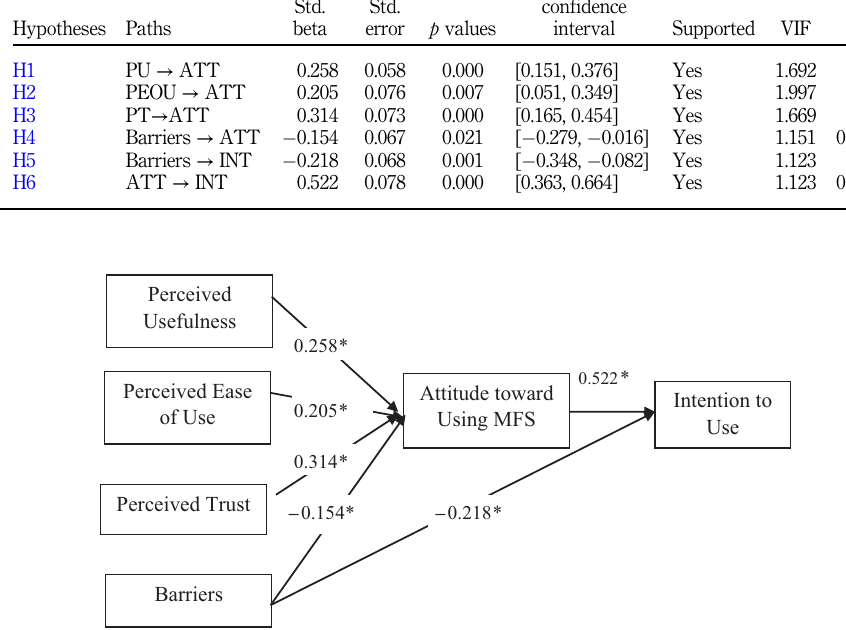
Figure 2. Structural